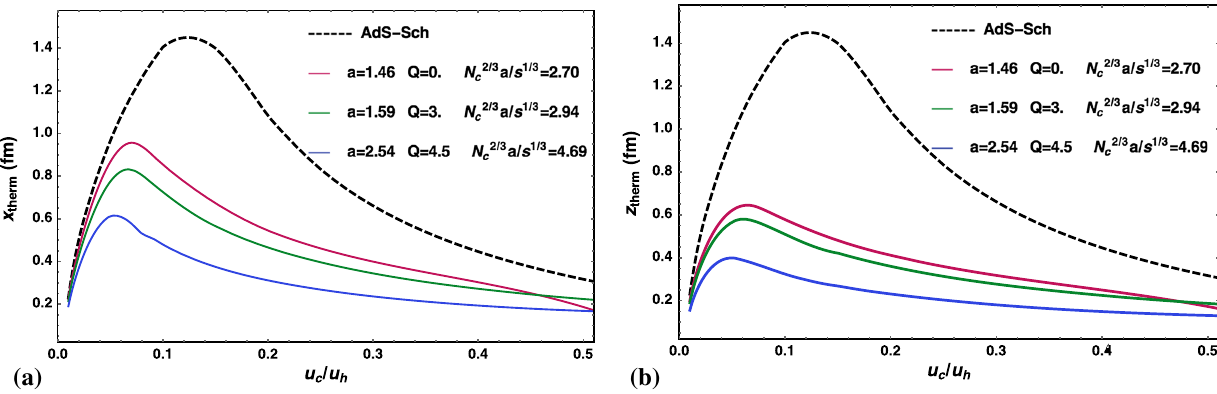
anisotropicplasmahasthesameentropydensityastheisotropicplasma, N − 2 c s = 0 . 159 GeV 3 . In all cases, the quark has 100 GeV energy, but created at different radial distance from the